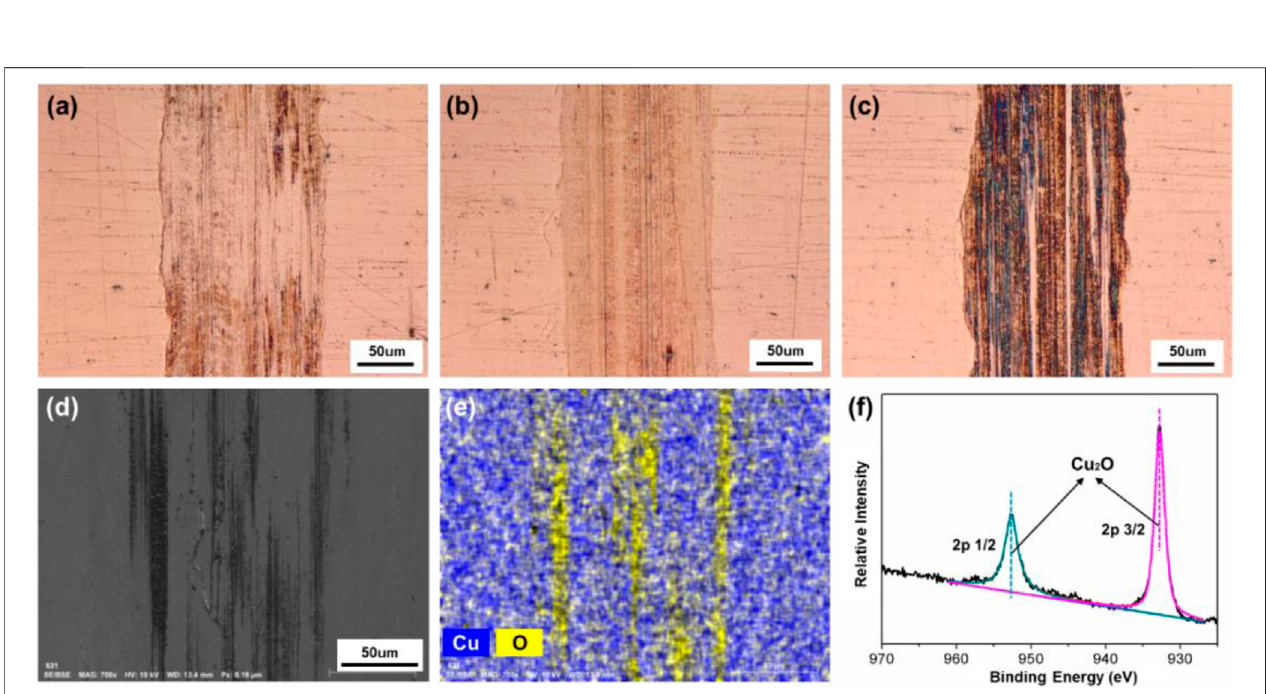
FIGURE 11 | Surface morphologies and compositions of the tracks on the Cu plates produced under different friction conditions with pure PC as lubricant. Microphotographs of the tracks obtained under different applied surface potentials: (A) 0 V, (B) − 2.0 V, and (C) +2.0 V. (D) SEM morphology, (E) EDS elemental map, and (F) XPS spectrum of Cu 2p of the tribo fi lms of the lower friction pair obtained under a positive surface potential of +2.0 V.